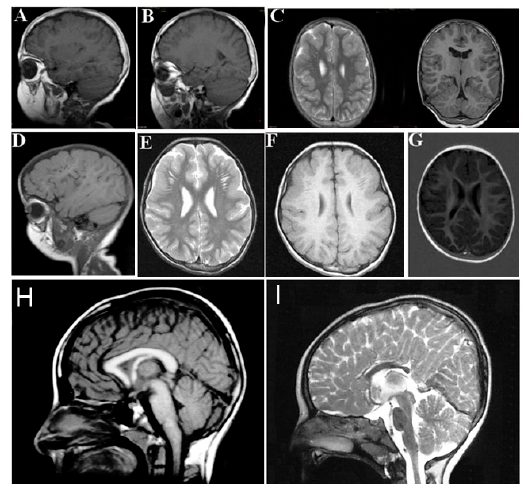
Figure 4. ( A , B , D ) demonstrate frontal and frontotemporal cobblestone-like brain dysgenesis on lateral T1 weighed images in three patients with cutis laxa IIA. Note the enlarged Virchow space under the abnormally-developed brain region; ( C , E , F ) shows sagittal images of fronto-temporal cobblestone-like brain dysgenesis on T2 and T1 weighted images in the same patients; ( G ) sagittal image showing mild, frontal cobblestone-like brain dysgenesis; ( I ) control showing normal-sized corpus callosum; and ( H ) agenesis of the corpus callosum in a cutis laxa IIB patient.